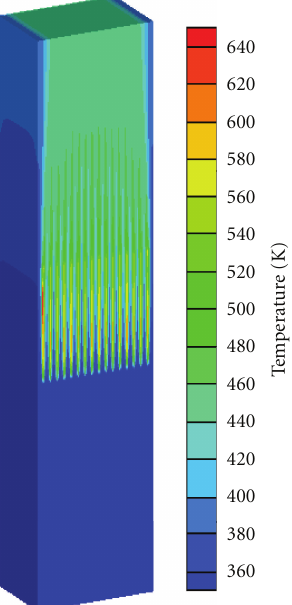
Figure 7: Temperature contour for simulation performed for Gx- test series (Gx-6).